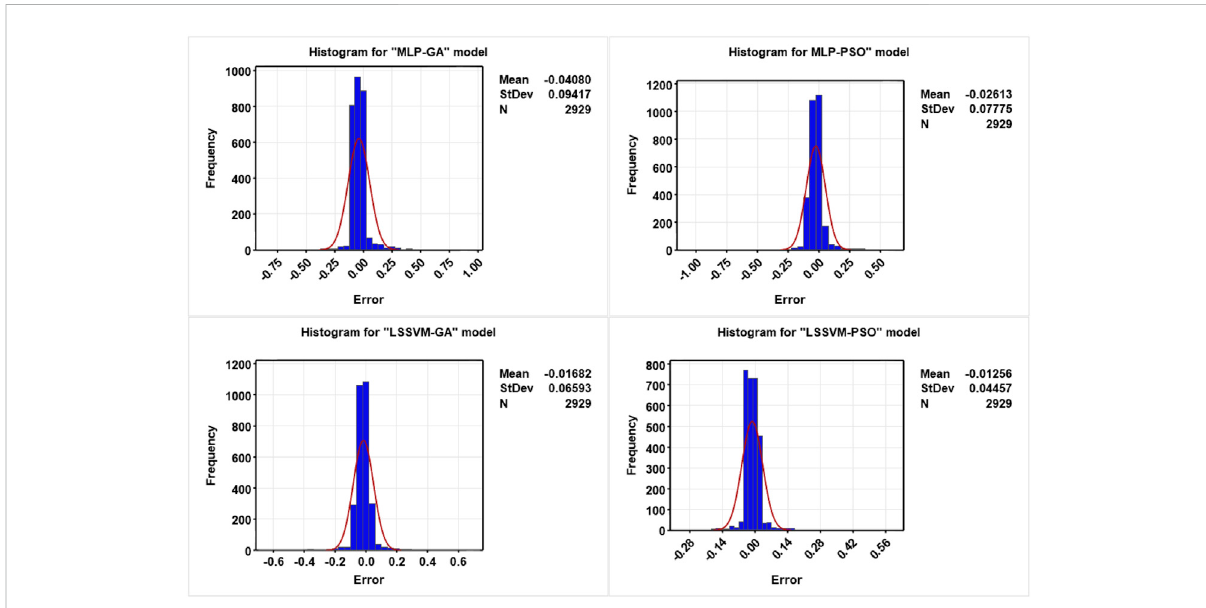
FIGURE 14 Fracturedensity ’ s(FVDC)histogram anddistributionlinefordeterminationofhighly accuracyfor fourrobousthybridmachinelearningLSSVM- PSO, LSSVM-GA, MLP-PSO and MLP-GA based on dataset of well #W1.